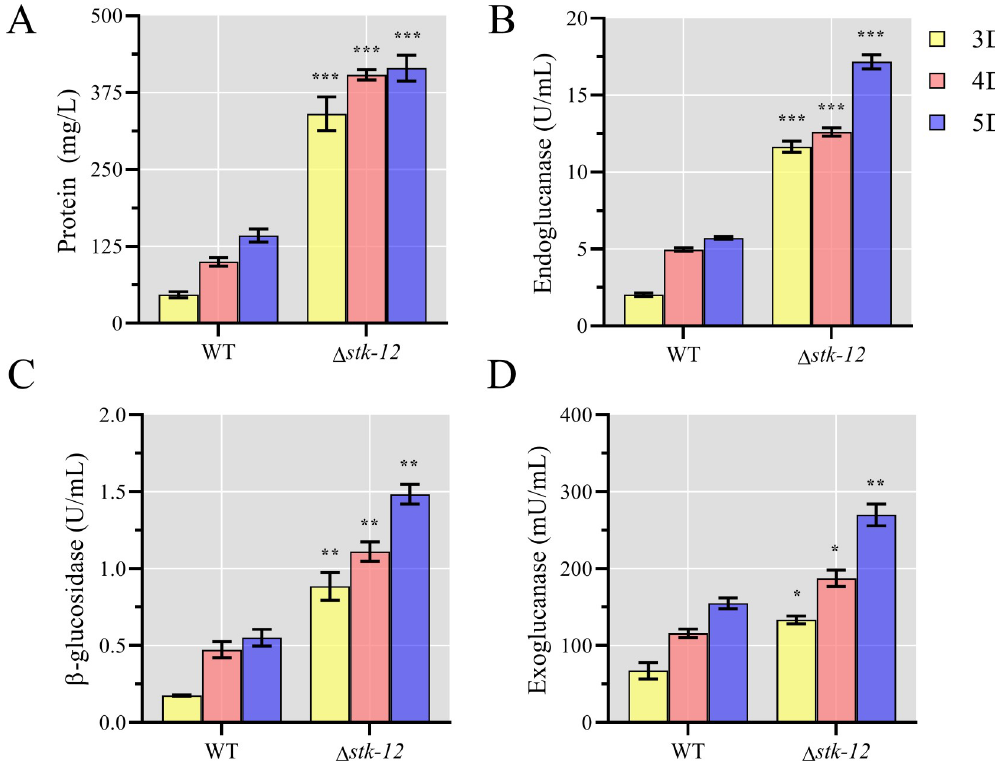
Fig 2. Hyper-production of lignocellulases by Neurospora crassa due to deletion of stk-12 . Conidia of Δ stk-12 and wild- type (WT) strains were separately inoculated into Avicel medium and batch cultured for 5 days. Total extracellular protein concentration (A), endoglucanase activity (B), β -glucosidase activity (C) and exoglucanase activity (D) were recorded. Values represent means of at least three replicates, error bars show standard deviation. Statistical significance was determined by two- tailed Student’s t -test ( � , P < 0.05; �� , P < 0.01; ��� , P <